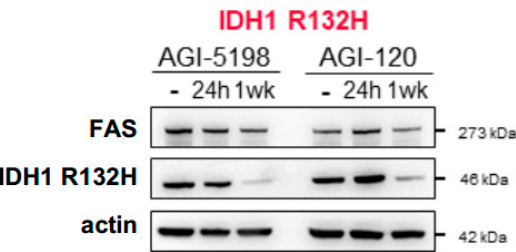
Figure 5. Fatty Acid Synthase (FAS) is linked to 2-HG production in IDH1 mutant cells. Lysates of IDH1 R132H AML cells in basal and following AGI treatments were immunoblotted with the indicated antibodies.